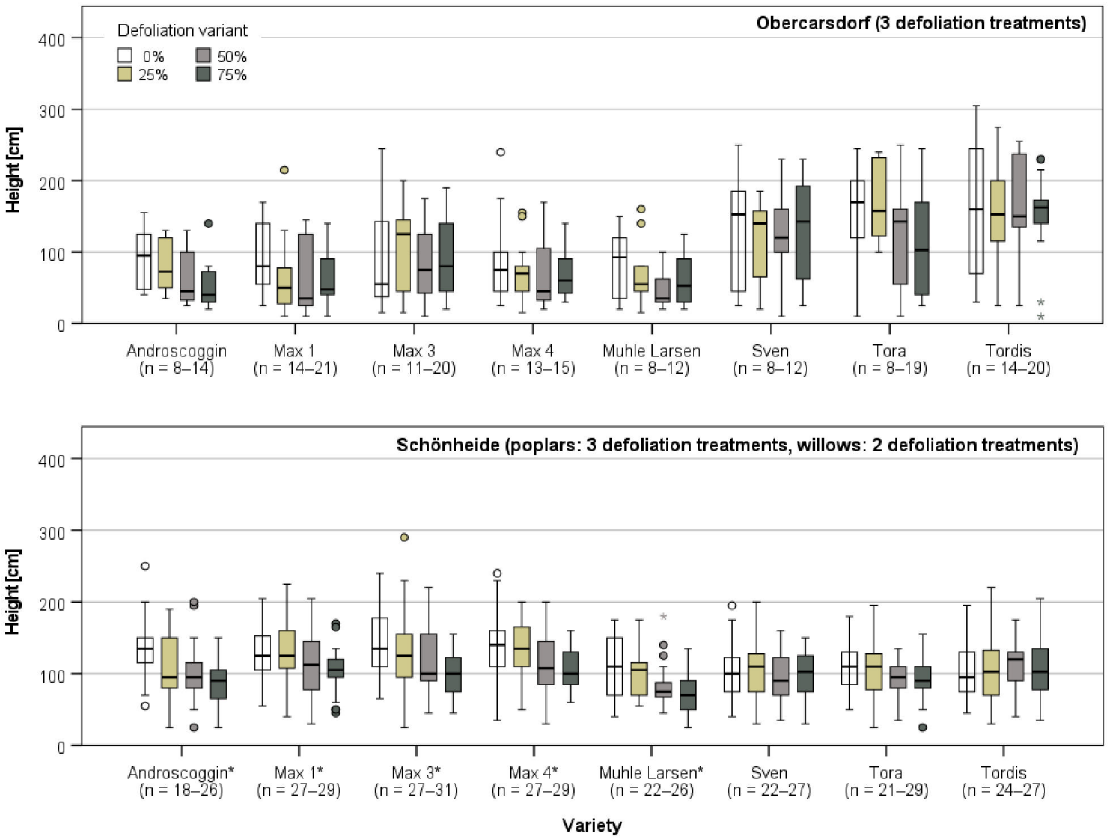
Figure 3. Height of poplar and willow varieties on the study sites in Obercarsdorf and Schönheide after two and/or three defoliation treatments prior to the start of the growing season in 2009 (n = range of number of plants per defoliation variant, * statistically significant difference according to ANOVA). Table 3. p values of pairwise comparisons of plant heights among defoliation variants (DVs) for both tree genera (green) as well as for all varieties with at least one significant value (orange) on the study sites in Obercarsdorf and Schönheide with regard to the number of defoliation treatments prior to the start of the growing season in 2009 via Tukey HSD test (bold values indicate statistically significant differences).